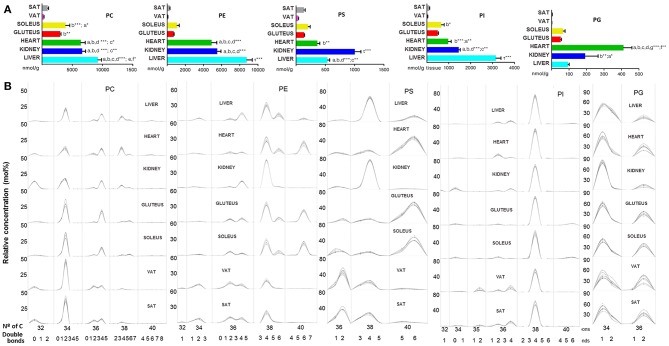
Glycerophospholipids within mammalian tissues detected by targeted lipidomic analysis. (A) Concentration of PC, PE, PS, PI, and PG subclasses. Values are expressed as mean ± SEM from 8 to 10 animals. Statistical analysis was one-way ANOVA and post-hoc Tukey significance is represented in the bar chart, meaning a significantly different respect to SAT, b respect to VAT, c respect to soleus, d respect to gluteus, e respect to heart and f respect to kidney, g respect to liver, τ respect to all. *p < 0.05, **p < 0.01, and ***p < 0.001. (B) Relative concentration of lipids normalized per sample to the total abundance within this lipid class to obtain molar fractions. Each solid line indicated tissue from an individual rat. Gray vertical lines separate lipids by total number of acyl chain carbons. The number of double bonds is indicated below within each group.